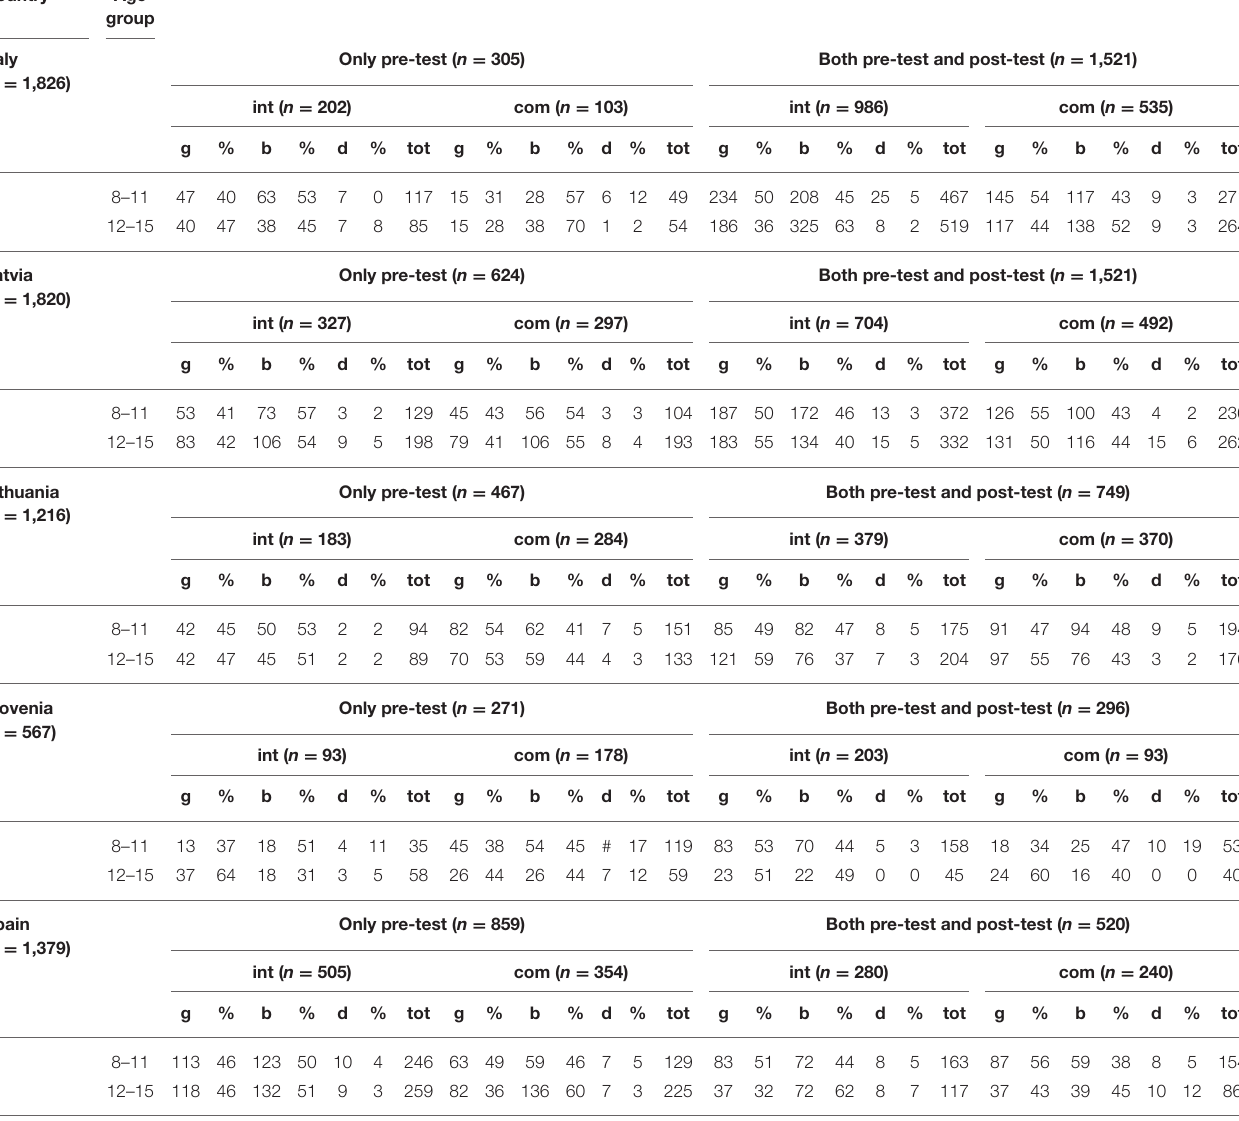
TABLE 3 | Students’ distribution as a function of age and gender across countries. Country Age group Italy ( n =